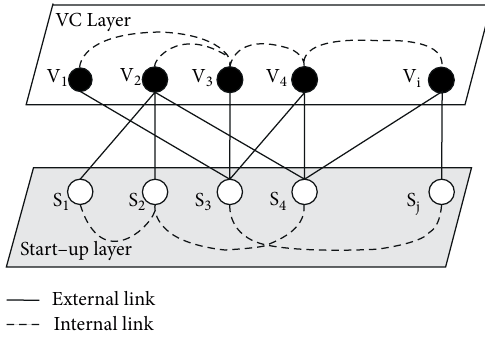
Figure 1: Schematic of a multilayer network to represent the risk contagion